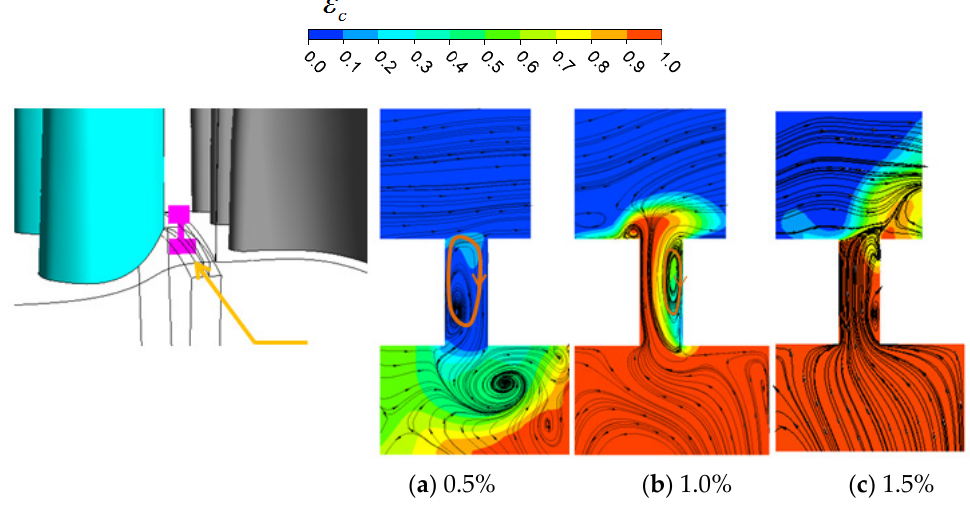
Figure 15. The sealing efficiency and streamline (t = 0T).